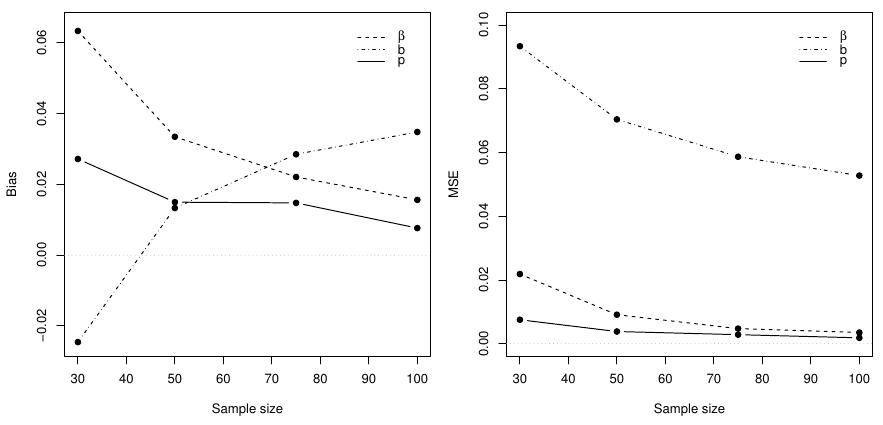
Figure 7. Bias and MSE of ˆ β , ˆ b and ˆ p for a simulated INAR-PncLII(1)